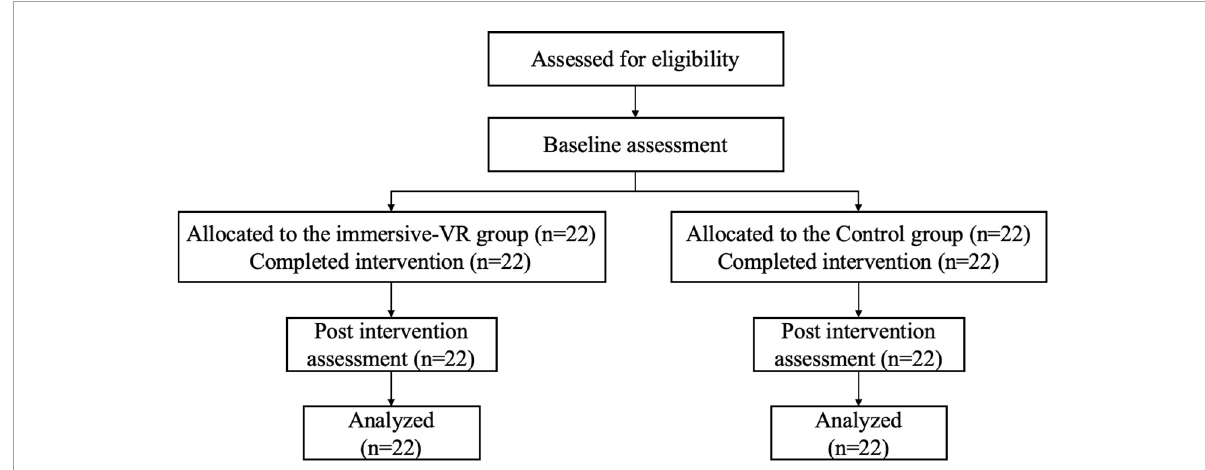
FIGURE1 The flow diagram of the study process. VR, virtual reality.